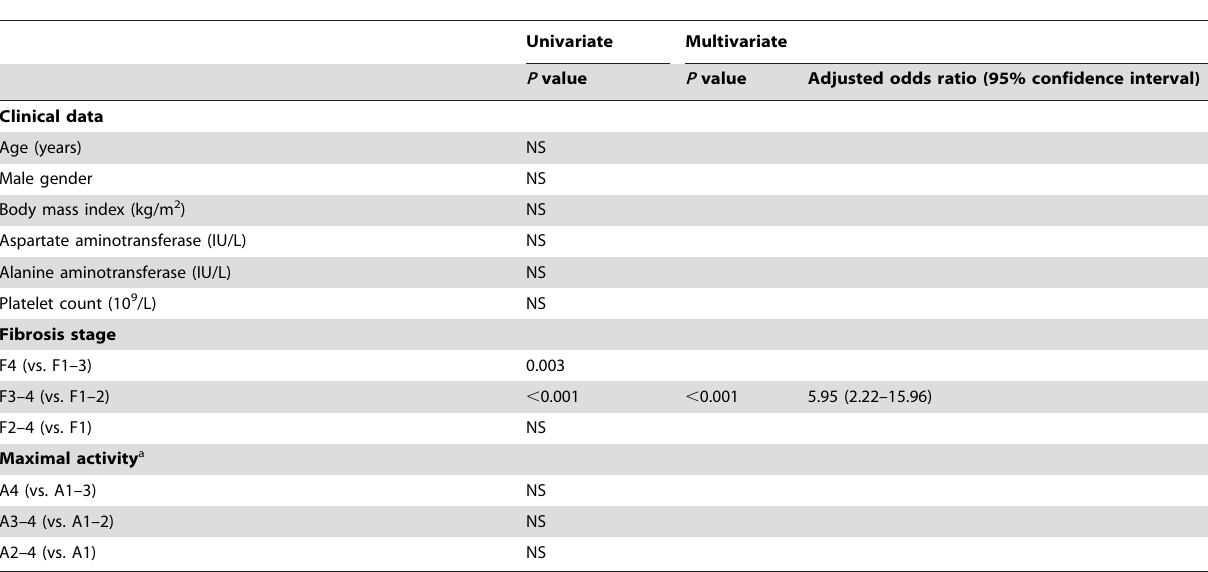
Table 5. Factors affecting discordance between FT and